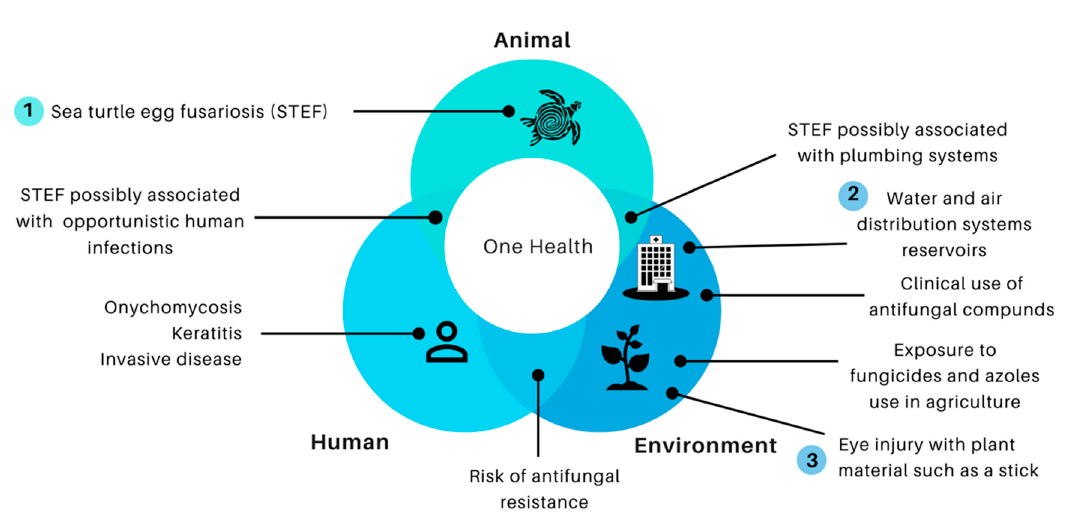
Figure 1. Animal, environment, and human interaction: a One Health perspective.